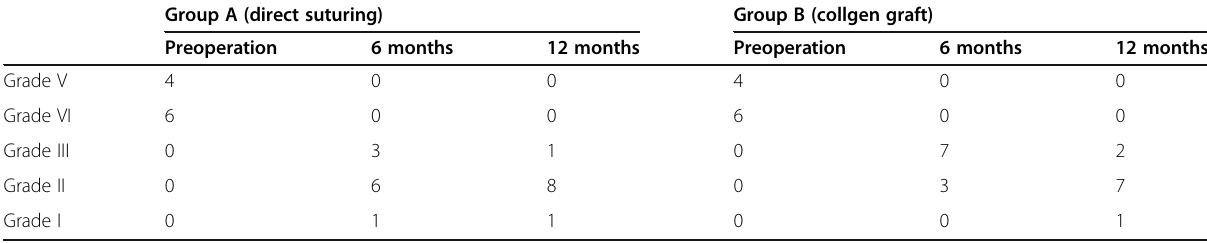
Group A (direct suturing) Group B (collgen